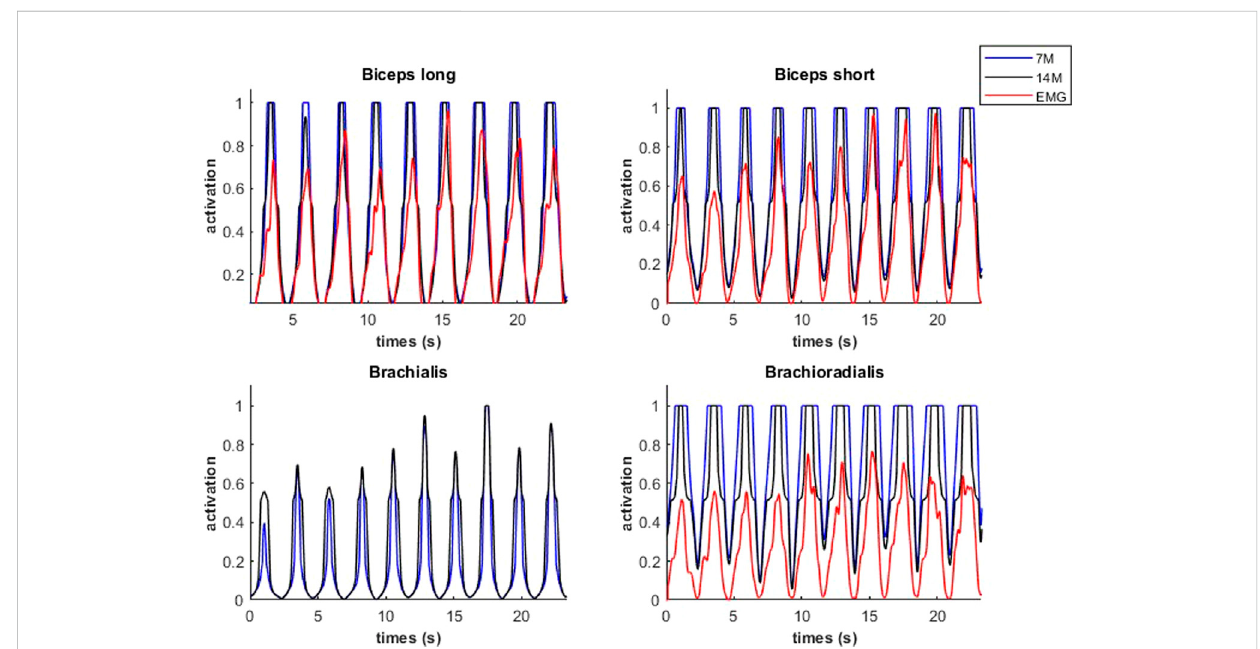
FIGURE 10 Muscular activations obtained through two muscle models, and EMG signals, during a weightlifting set of 10 bicep curls, using physiological optimization.